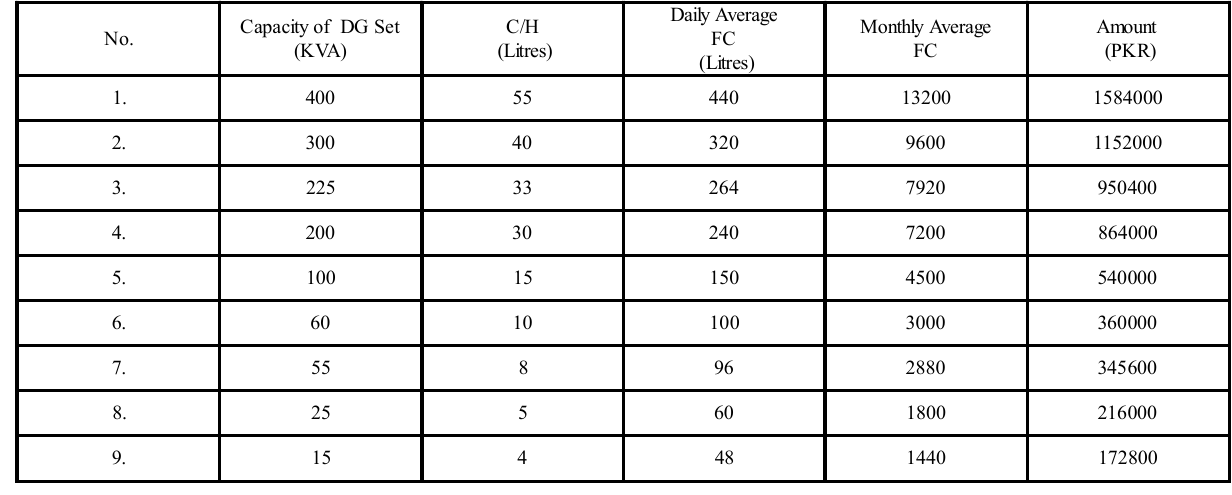
TABLE 3. CHART SHOWING OPERATION COST (AUTO